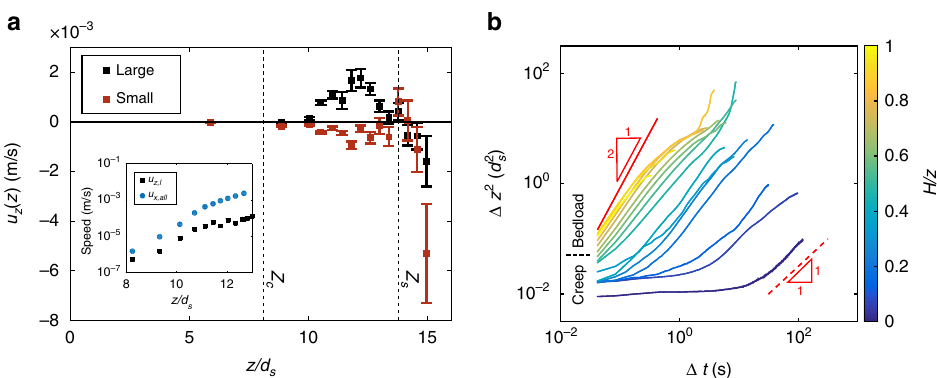
Fig. 2 Experimental particle and segregation dynamics. a Vertical velocity pro fi le for small and large grains for the interval Δ t = [0:20] min at the beginning of shearing at Shields number τ (cid:1) s ¼ 4 : 1 τ (cid:1) cs . The elevations of the bed surface ( z s ) and transition to creep ( z c ) are indicated. Inset shows the horizontal streamwise velocity u x pro fi le for all grains and vertical velocity for large grains u z , l in logarithmic scale for the bedload zone. The streamwise particle velocity measurements have error-bar (one standard deviation/mean) value ~0.3%, whereas vertical particle velocity measurements have error-bar (one standard deviation/mean) value ~1%. b Vertical mean-square displacement (MSD) for large grains as a function of time Δ t . MSD shown for various depths of the granular bed, de fi ned with a colorbar. The top and bottom red-dashed lines indicate the limiting behaviors of advection and diffusion, respectively. Boundary between bed load and creep is indicated. Note that near-surface grains are advective at short times; creeping grains show no change in MSD at short times indicating caged dynamics, but transition to diffusive behavior at longer